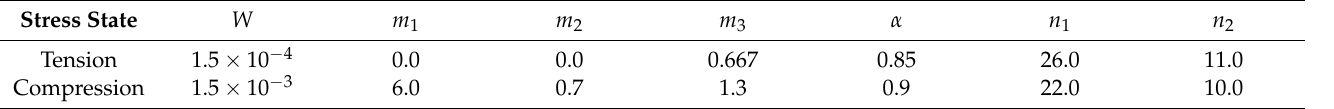
Table 4. The material parameters in the fatigue damage